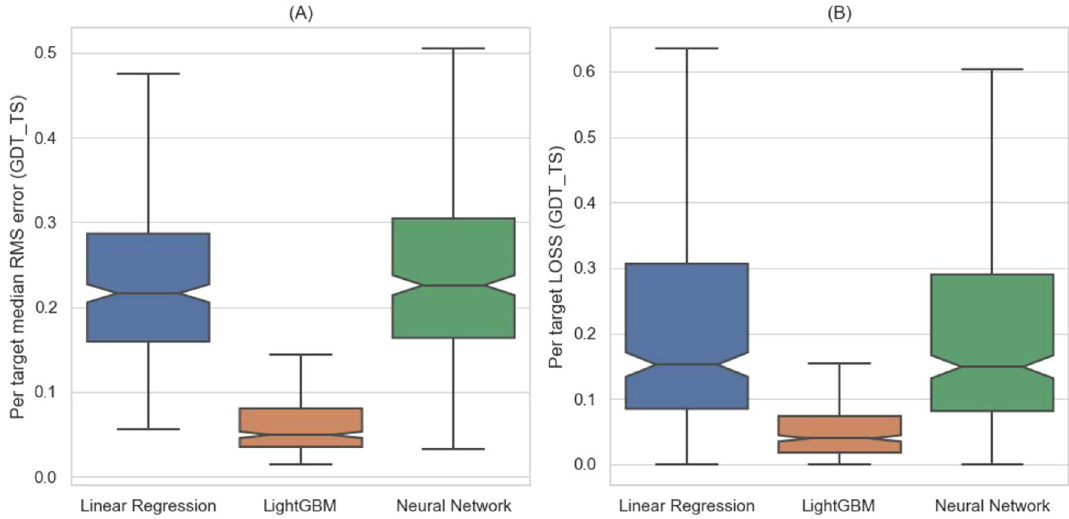
Figure 2. LightBGM 61 outperforms linear regression and neural networks. The box plots depict the results of Leave-One-Target-Out experiments in terms of RMSE (A) and LOSS (B) , using three different regressors. The difference in performance between LightBGM and the two other methods is statistically significant (Wilcoxon one-sided test with a p-value < 1.39e−51). The performances of few other tree-based methods were practically indistinguishable from LightBGM (data not shown) but computation time was much longer.